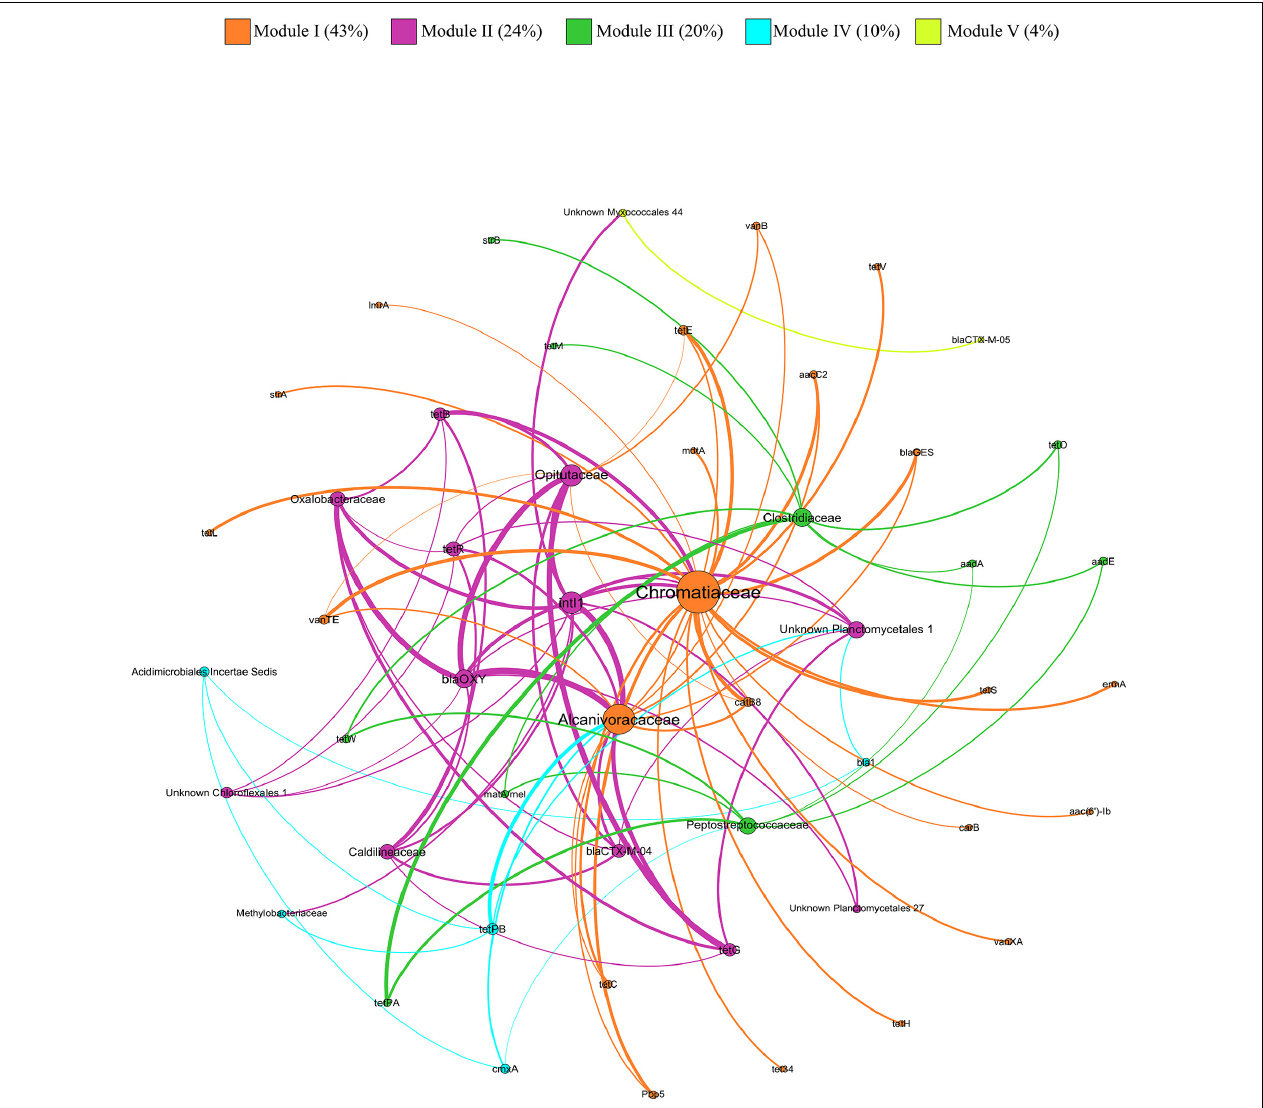
FIGURE 7 | Network analysis of ARGs, MGE-genes (relative abundances) and 12 multi-resistant bacterial families based on Kendall’s correlations. Node size is proportional to the number of connections (degree). An edge represents a significant correlation, where the edge thickness is proportional to Kendall’s correlation coefficient